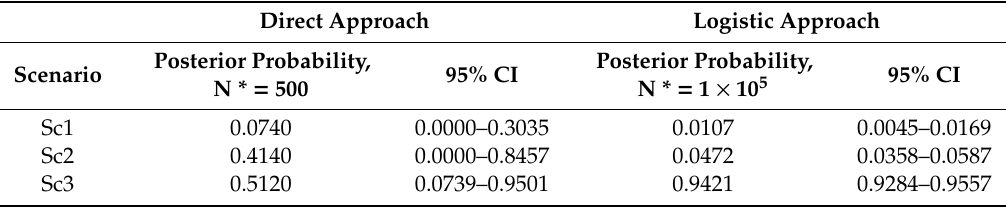
Table 4. Posterior probabilities of the three biogeographic scenarios.